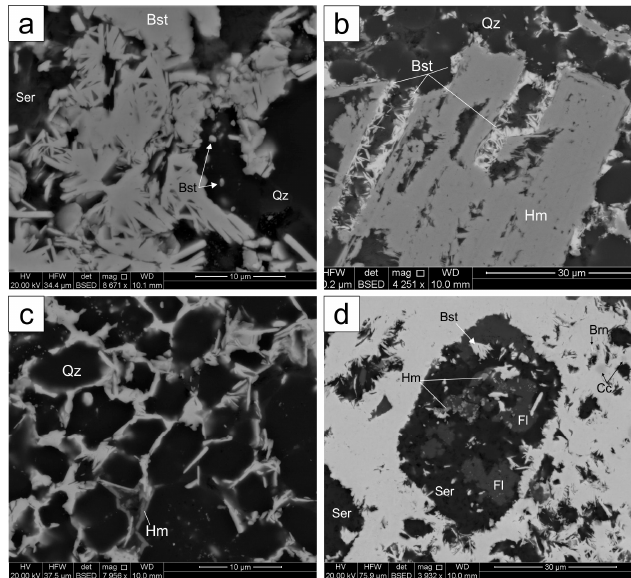
Figure 2. Backscatter electron (BSE) images showing textural aspects of fine-grained matrix bastnäsite: ( a ) Fine-grained bladed matrix bastnäsite (Bst) concentrated along boundaries of other gangue minerals (quartz-Qz, sericite-Ser) in the breccia matrix (sample RX6717); ( b ) Platy bastnäsite on hematite (Hm) and interstitial between quartz (sample RX6719); ( c ) Detail of ( b ) showing fine-grained bladed bastnäsite (white) interstitial to quartz with hematite; ( d ) Aggregated fine-grained matrix bastnäsite as a cement for other minerals (fluorite-Fl, hematite, sericite) within the breccia. Minor brannerite (Brn) and chalcocite (Cc) are enclosed by bastnäsite cement (sample RX6719).